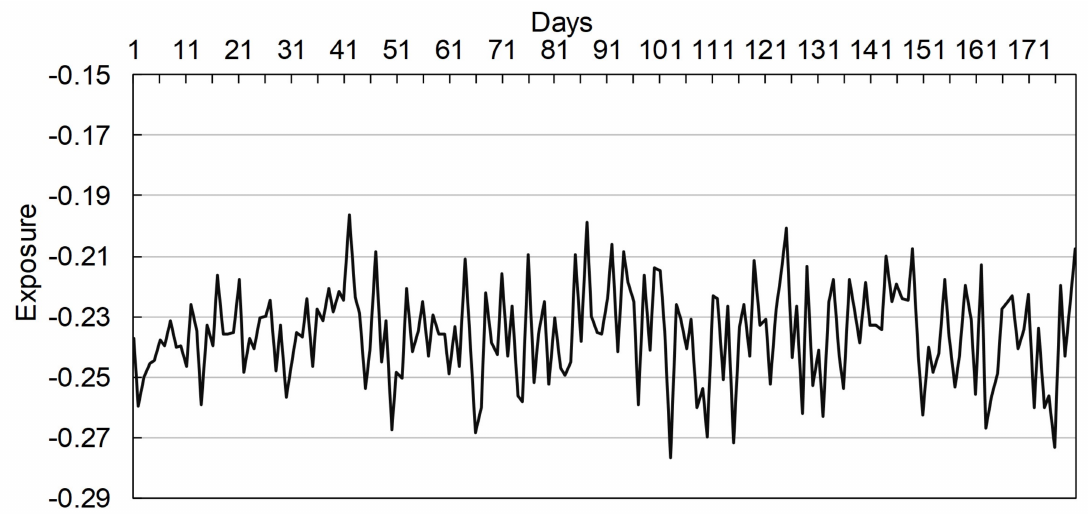
Figure 7. Changes in exposure to environmental stressors if a construction is blocking one route for agent Bob. The x-axes shows the days, and the y-axes show the exposure differences between winter and summer